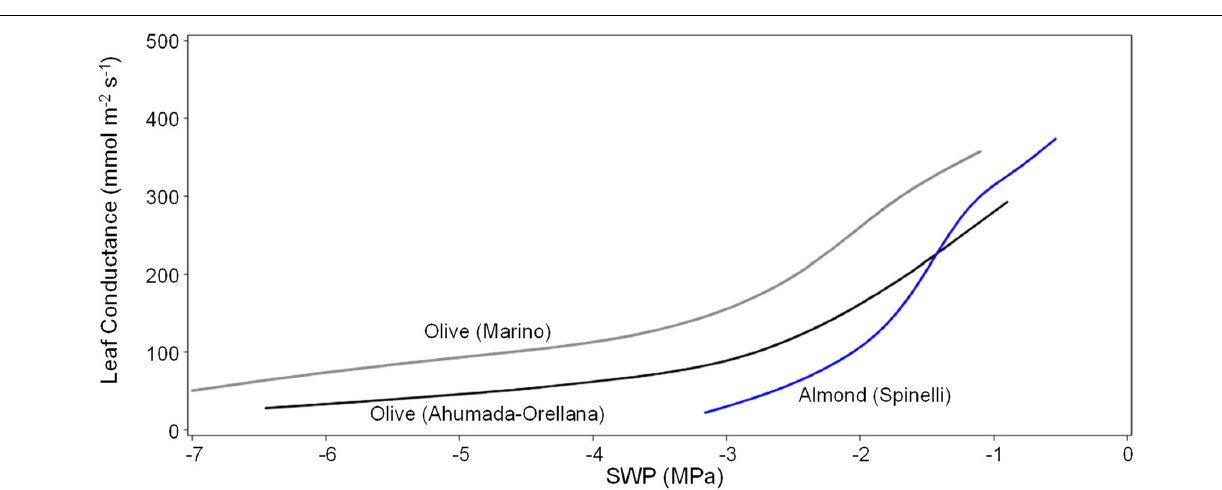
FIGURE 7 | Relation of leaf conductance to SWP for almond reported by Spinelli et al. (2016), for olive reported by Marino et al. (2018), and for olive reported by Ahumada-Orellana et al. (2019). Each line is a 60% smoothed spline function fit to the raw data (Proc Transreg SAS